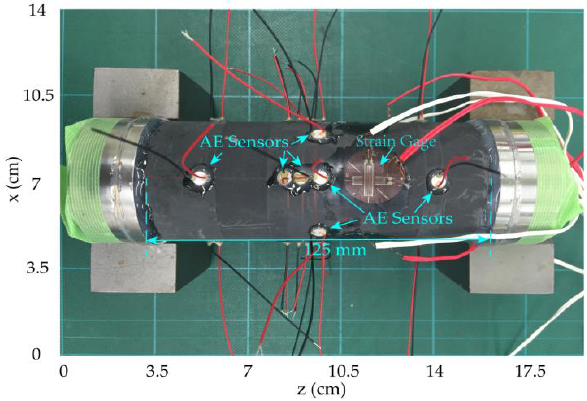
Figure 2. The shale column with the AE sensors and strain gauge installed on it.